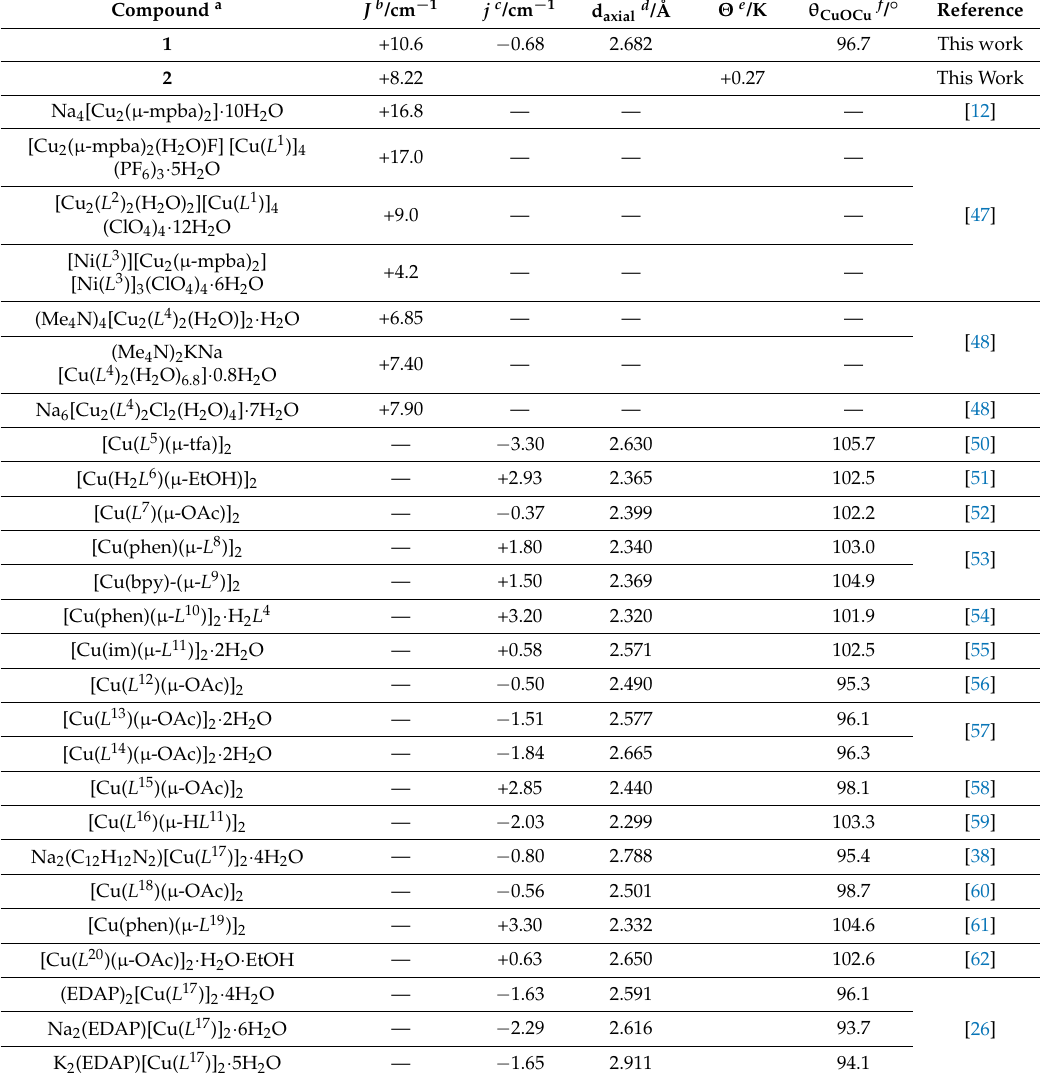
Table 4. Comparison of the magnetic exchange between copper(II) ions in 1 and in other dicopper(II) meta -substituted phenyl(pyridyl) bis-oxamate or double out-of-plane µ -oxo(carboxylate) complexes. Compound